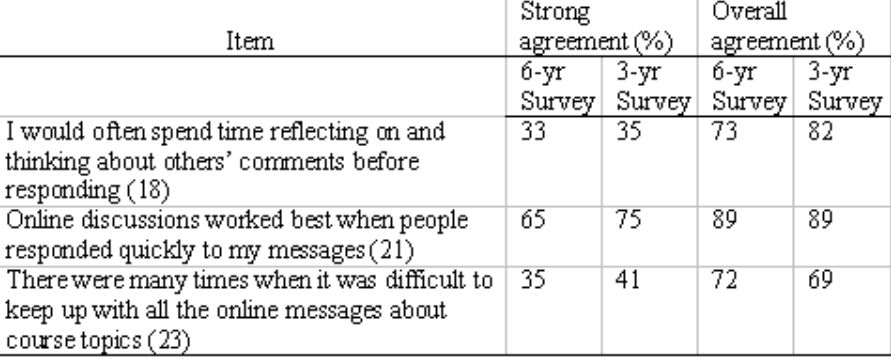
Table 4 points to a tension in the use of asynchronous online communication. The programme requirement of reflective comment was a good match with the affordances of